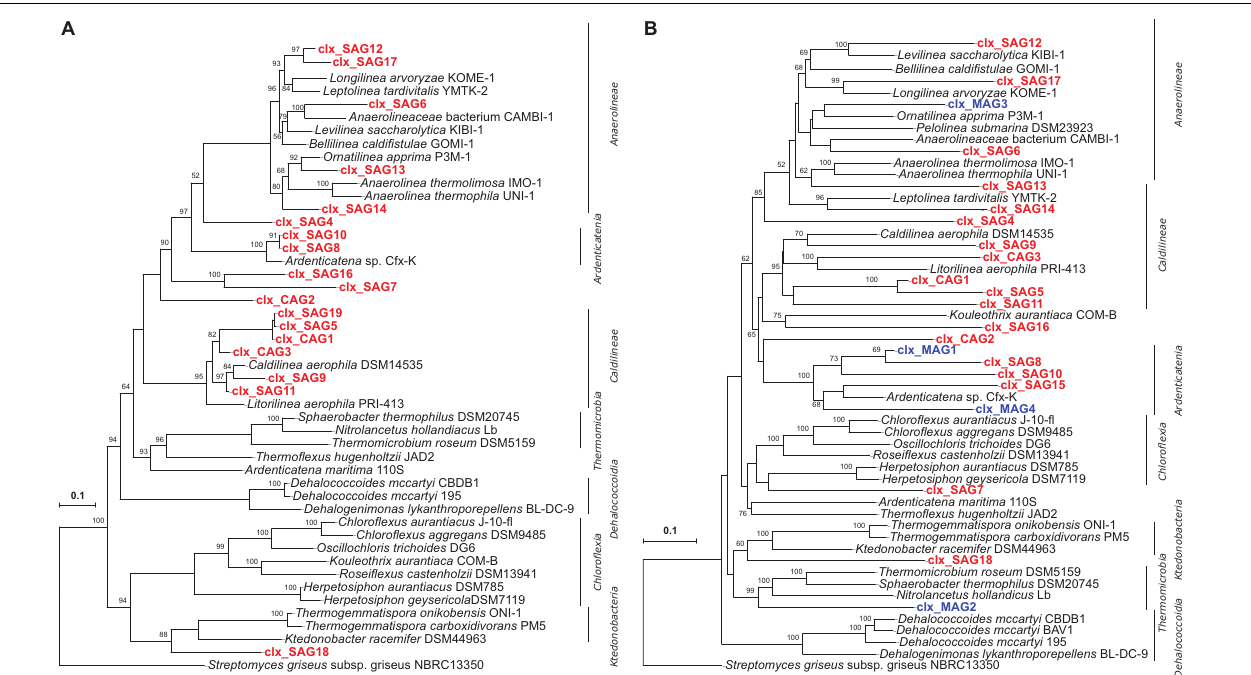
FIGURE 4 | Phylogenetic analysis: (A) 16S rRNA genes of Chloroflexi single amplified genomes (SAGs) constructed using the Arb software. Partial 16S rRNA genes of approximately 500 bp were amplified from SAGs; their sequences were aligned using the online SINA platform and imported into Arb. 16S rRNA gene sequences extracted from genomes of Chloroflexi isolates are included as references. (B) Distance-based phylogeny on the basis of gene content of Chloroflexi genomes obtained via SCG and metagenomics approaches. Classification at the class level is given on the right. Streptomyces griseus is used as an outgroup. Nodes with bootstrap values of more than 50 are presented in the tree. Scale bars indicate a 10% sequence divergence.